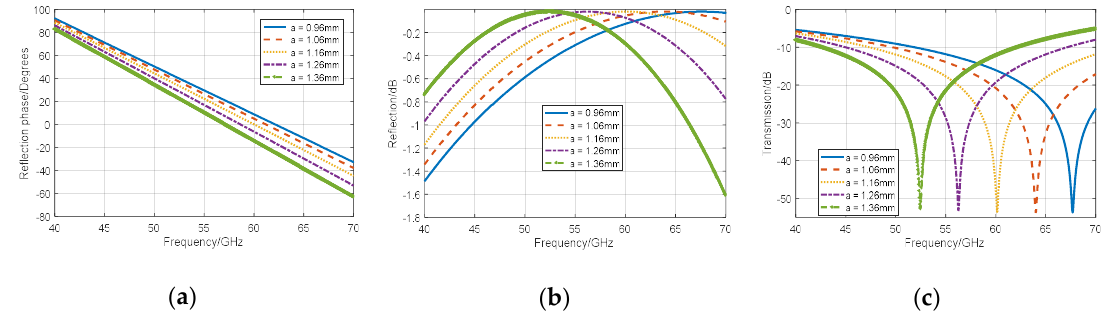
Figure 6. Reflection phase, reflection coefficient and transmission coefficient of the dual loop metasurface at varied square loop length, ‘a’: ( a ) Reflection phase, ( b ) reflection coefficient and ( c ) transmission coefficient.